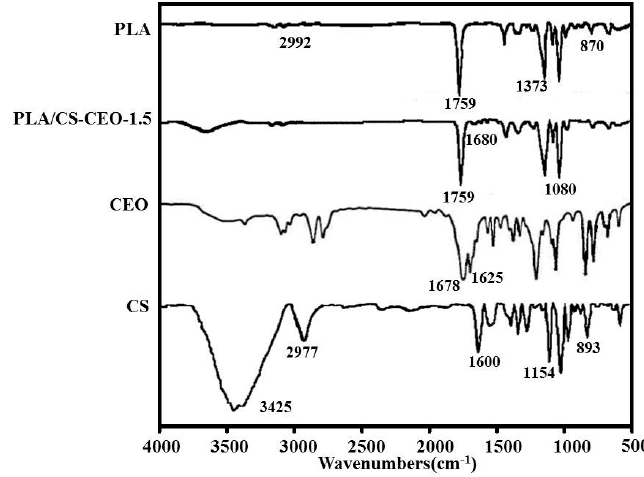
Figure 4. FT-IR spectrum of PLA, CEO, CS, and typical PLA/CS-CEO-1.5 fibers.